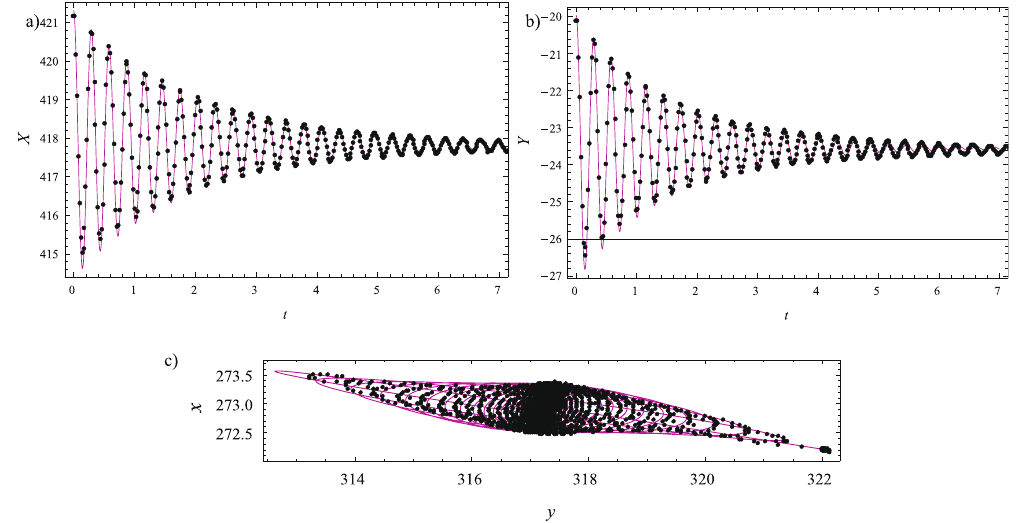
Figure 10. Marker 1: ( a ) Comparison of the transformed experimental results (magenta solid line) and the fitted numerical results (black dots) along the X -axis; ( b ) Comparison of the transformed experimental results (magenta solid line) and the fitted numerical results (black dots) along the Y -axis; ( c ) Comparisons for the trajectories.